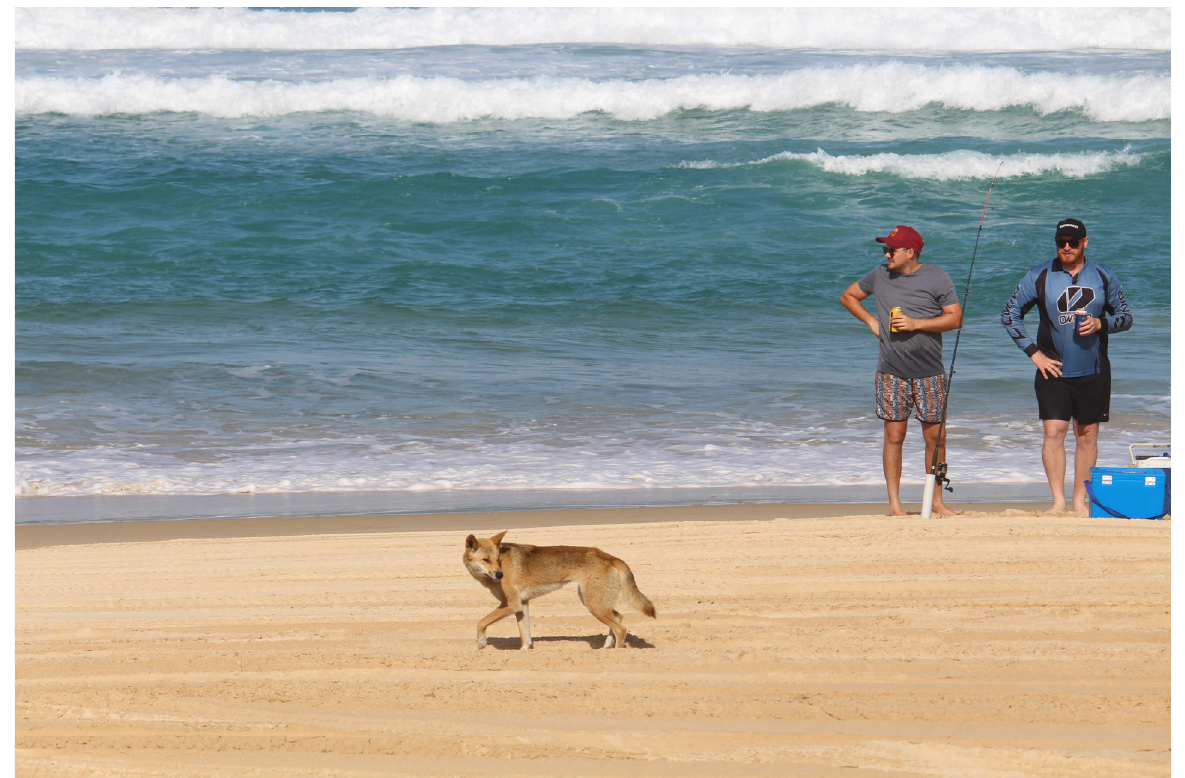
Figure 4. A dingo on K’gari (Fraser Island). This free-ranging individual is habituated to the presence of humans, as are many others on this popular holiday destination where people regularly camp, fish, and engage in other recreational activities in wild dingo habitat. Credit: Frankie Dixon (Unsplash).